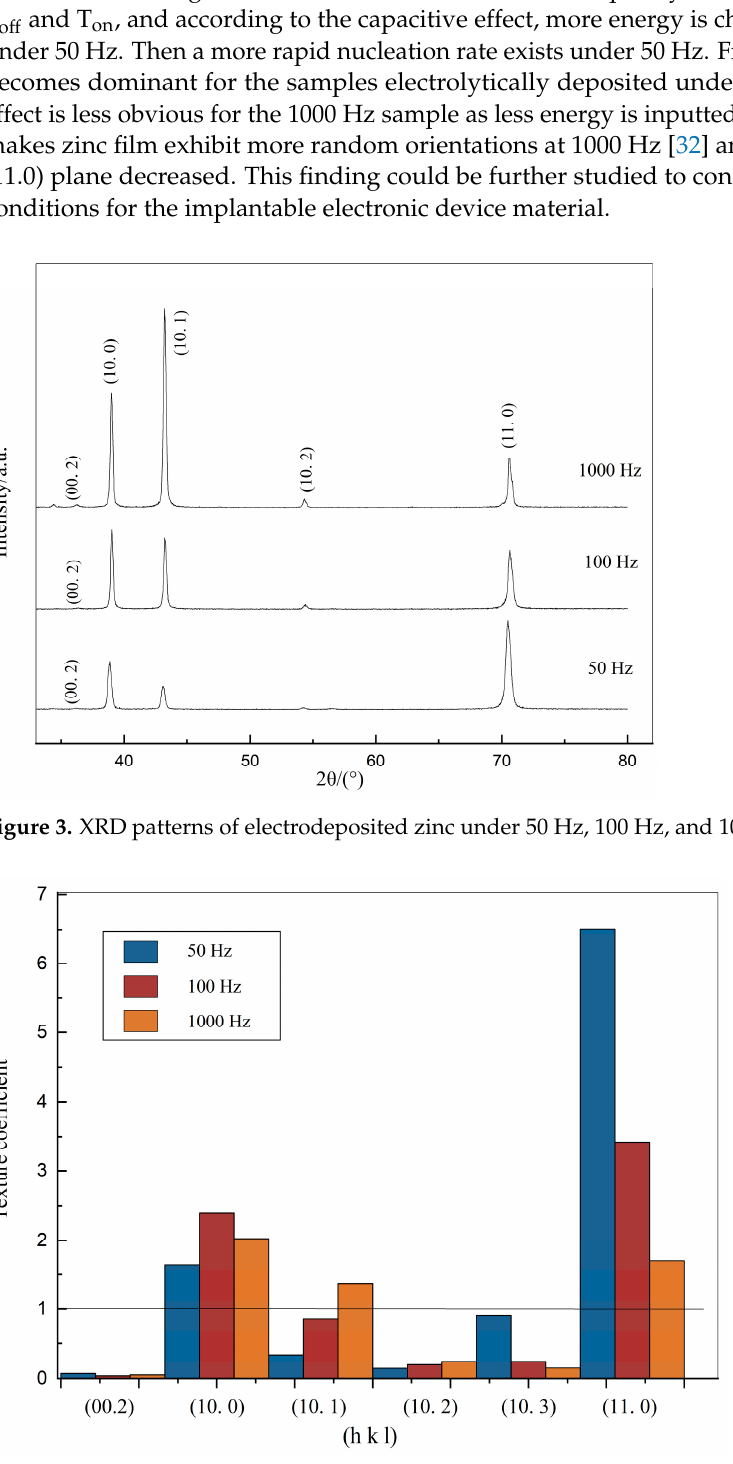
Figure 4. Tc chart of electrodeposited zinc under 50 Hz, 100 Hz, 1000 Hz pulse frequency.